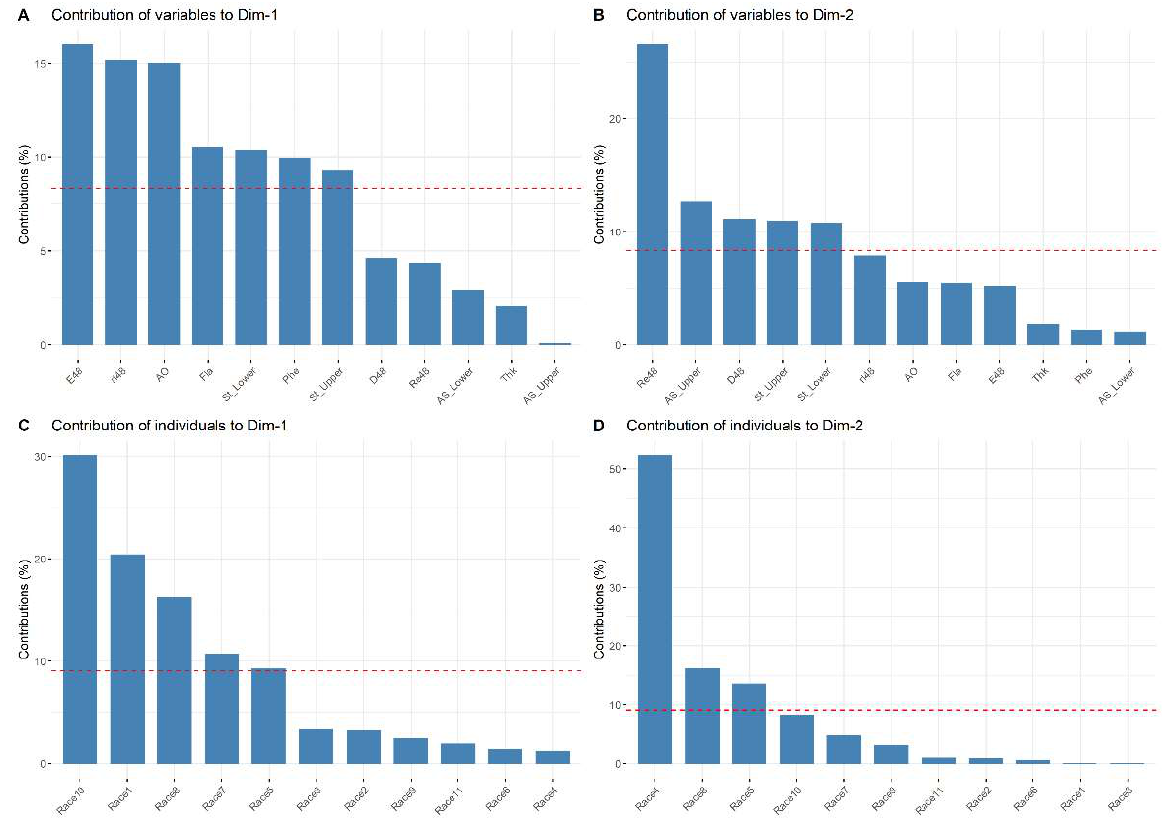
Figure 3. Contribution of the variables ( A , B ) and maize races ( C , D ) at 48 h. The dotted red line indicates the expected average contribution of the variable and maize race. Variables or maize races with a contribution larger than this cutoff is considered important in contributing to component.